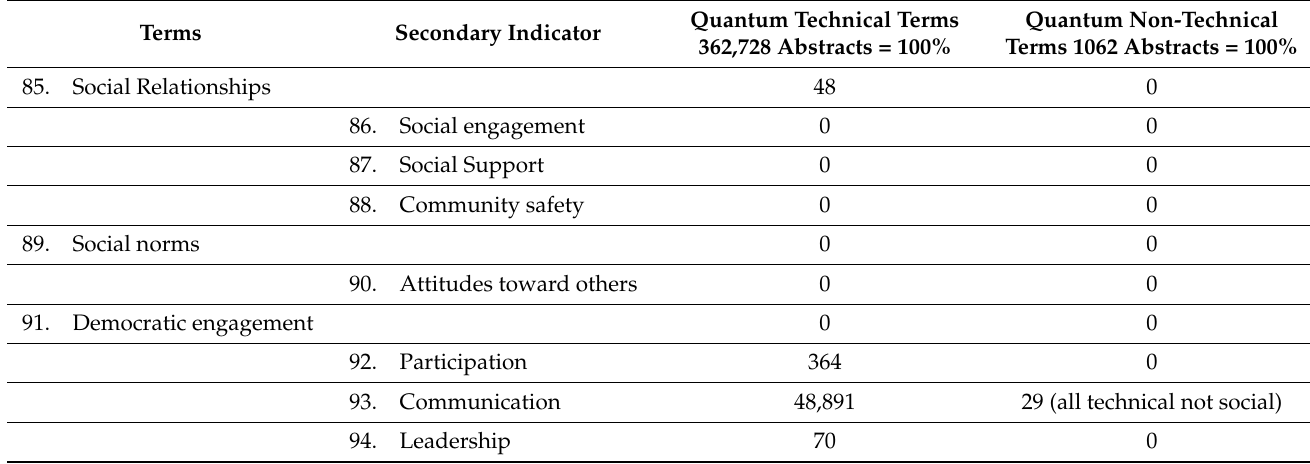
Table 6. Presence of Canadian Index of Wellbeing indicators in conjunction with the quantum terms